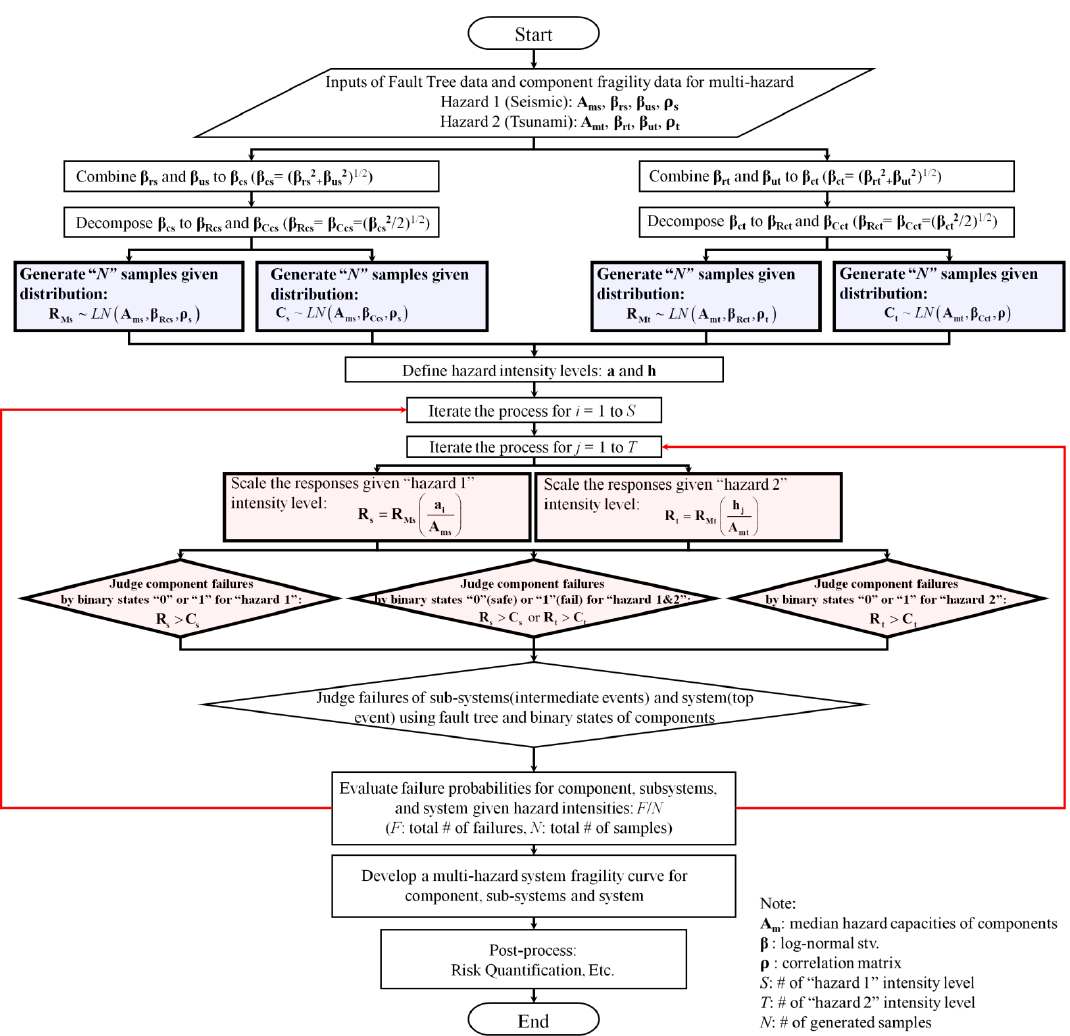
Figure 2. Flowchart of improved DQFM algorithm (“proposed”) for multi-hazard risk assessment.